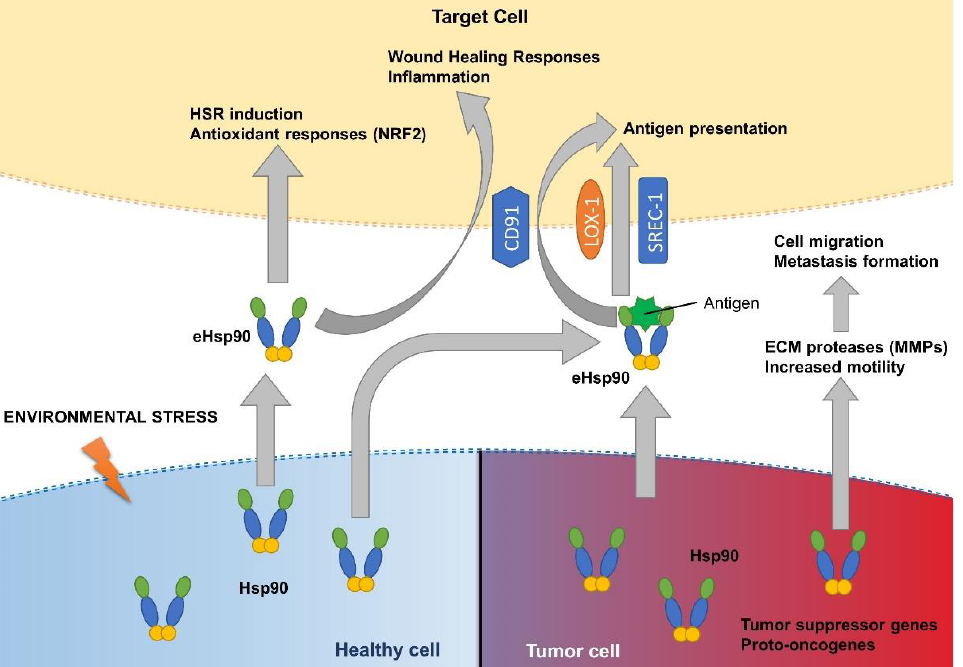
Figure 3. Extracellular functions of Hsp90. Hsp90 is secreted in response to various stresses from normal or from tumor cells. Outside the cell, eHsp90 exhibits various functions, including wound- healing and inflammation, antigen presentation, antioxidant signaling, or restructuring of the ECM, promoting cell migration and metastasis formation.